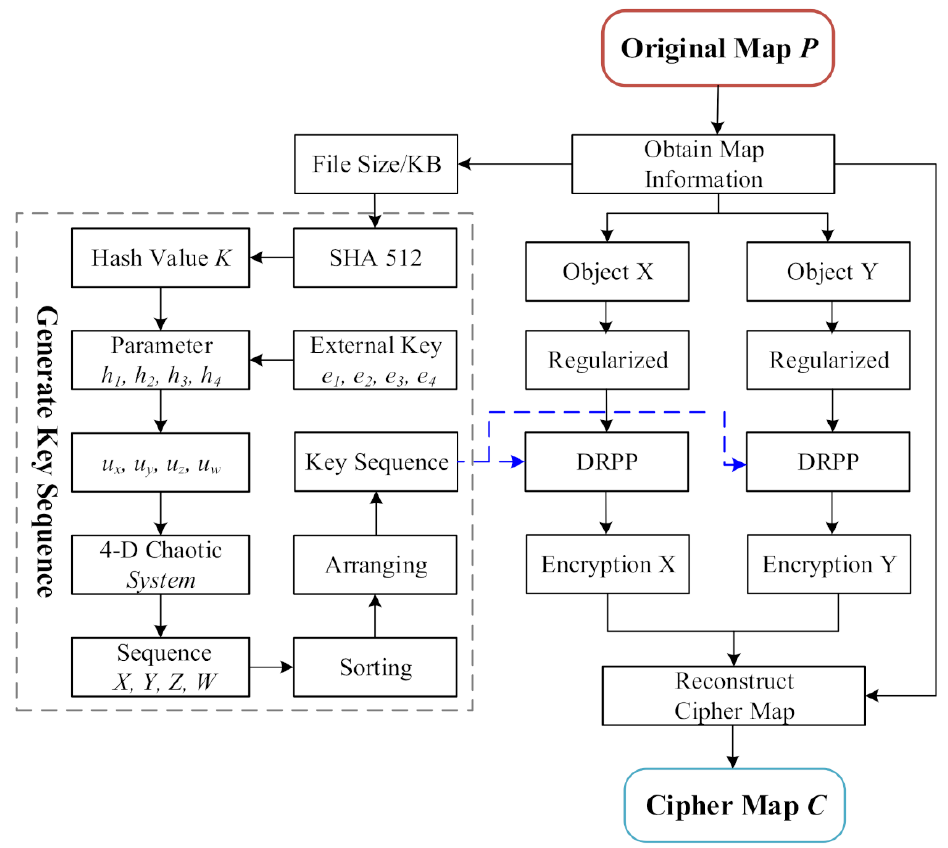
Figure 6. The diagram of the proposed encryption